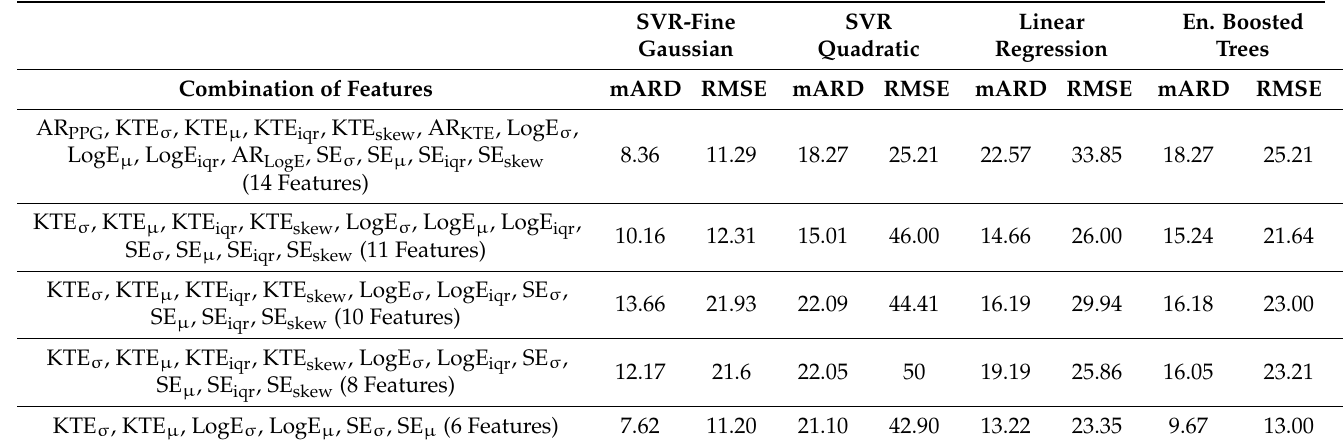
SVR-Fine Gaussian